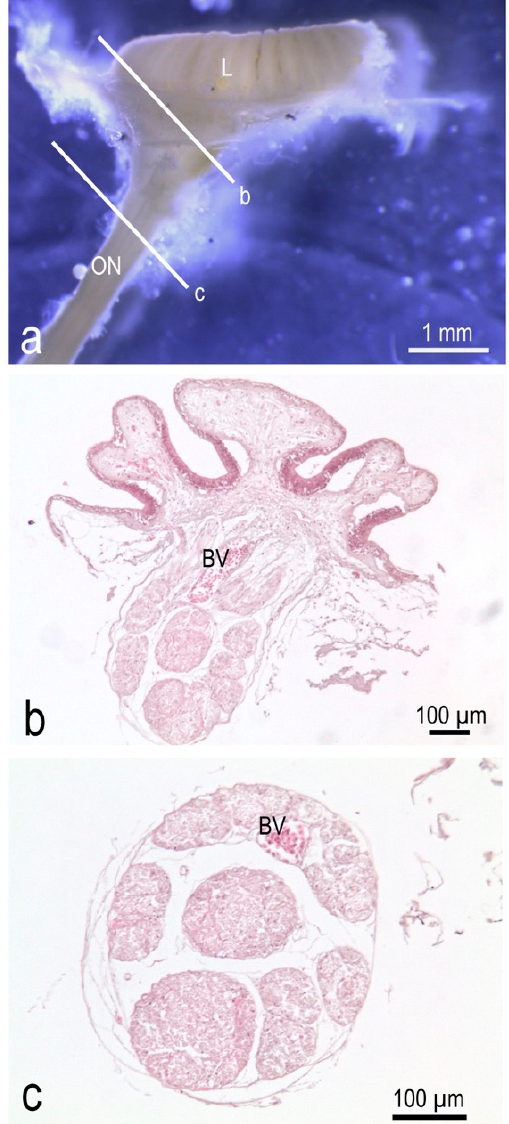
Figure 6. Gross morphology and histology of the olfactory rosette and nerve of P. antarcticum . ( a ) Lateral view of an olfactory rosette with the olfactory nerve. The two lines indicate the cutting plane of histological photographs in ( b , c ). ( b ) Hematoxylin-Eosin; the fila olfactoria gather to form the olfactory nerve in the connective tissue under the raphe. The large blood vessel that runs along the raphe, follows the fila olfactoria. ( c ) Hematoxylin-Eosin; transverse section of the olfactory nerve. BV = blood vessel; L = lamellae; ON = olfactory nerve.